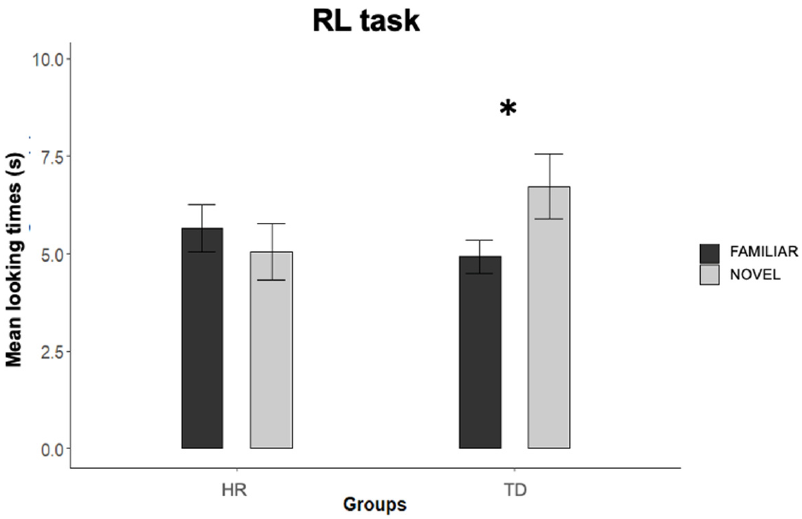
Figure 4. Mean looking times to the familiar and novel test trials for the HR infants and the TD infants. Error bars represent standard error of the means; * p < 0.05.